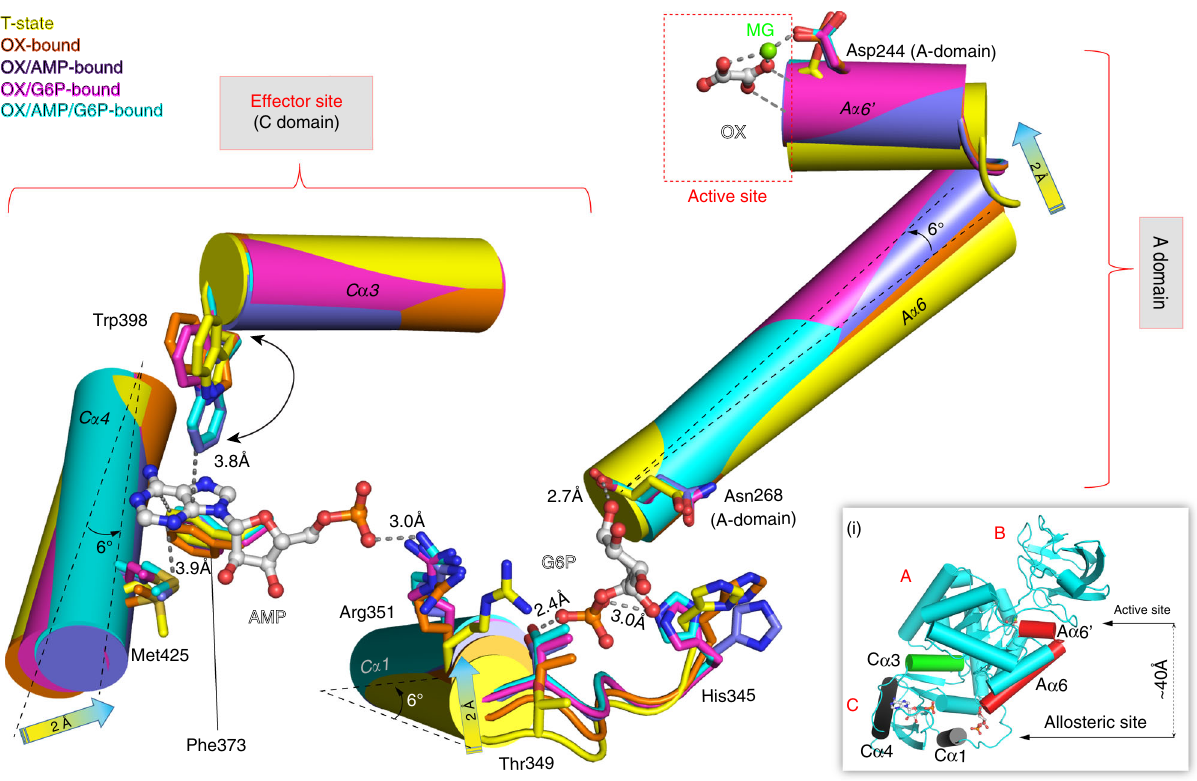
Fig. 5 Local conformational rearrangements within the C domain induced by the effectors binding in a synergistic manner. Effector-site superposition of fi ve Mtb PYK structures in different ligand-bound states showing the structural rearrangements of the synergistic mechanism. The polypeptide chains are shown as cartoons, while interacting residues are shown as sticks. The carbon atoms of the effectors AMP and G6P are represented by grey sticks. The movements of α helixes (C α 1, C α 4 and A α 6 ′ – A α 6) and the fl ip of the side chain of Trp398 are indicated by arrows. Interactions between Mtb PYK and the effectors are shown as dashed lines, together with the corresponding distances. The relative locations of the fi ve implicated α helixes within a subunit are shown in the inset (i) where the active site, allosteric effector-binding site and domains are indicated. The α helixes C α 3 and A α 6 ′ – A α 6 are shown as green and red, respectively. The distance between the active site and effector is about 40